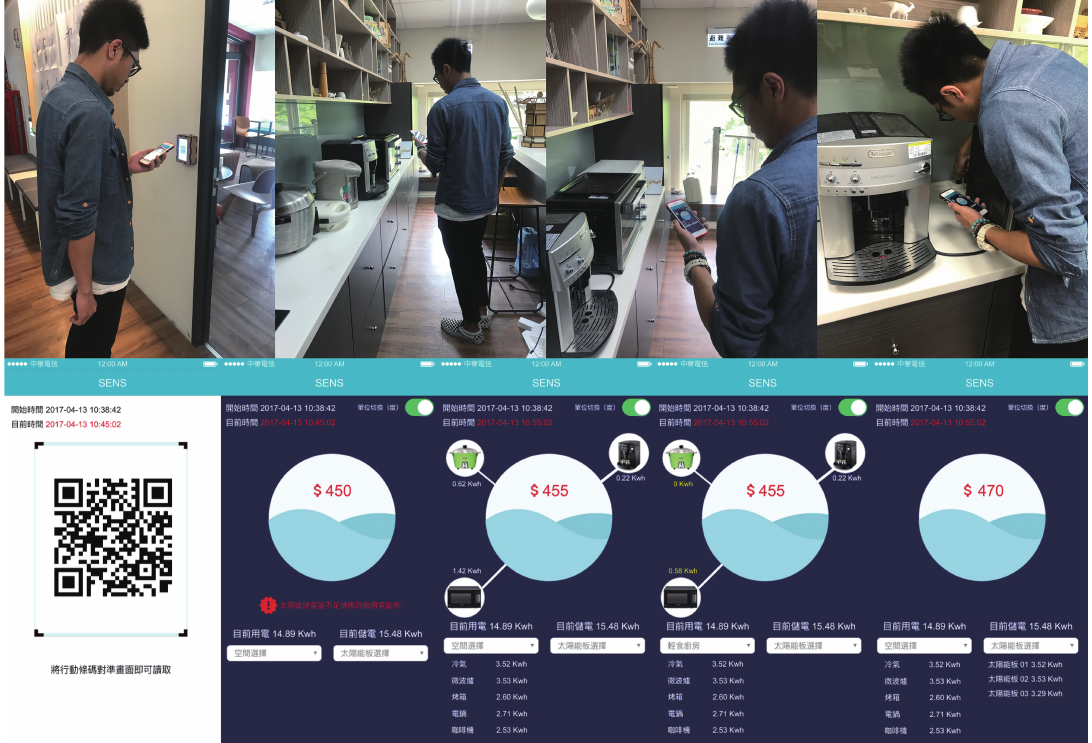
Figure 9. Scenario Simulation For the App and